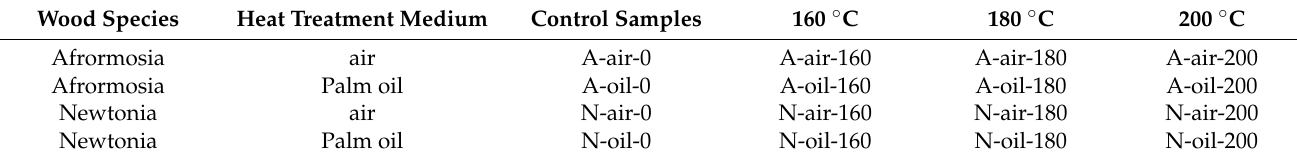
Table 1. Labelling of